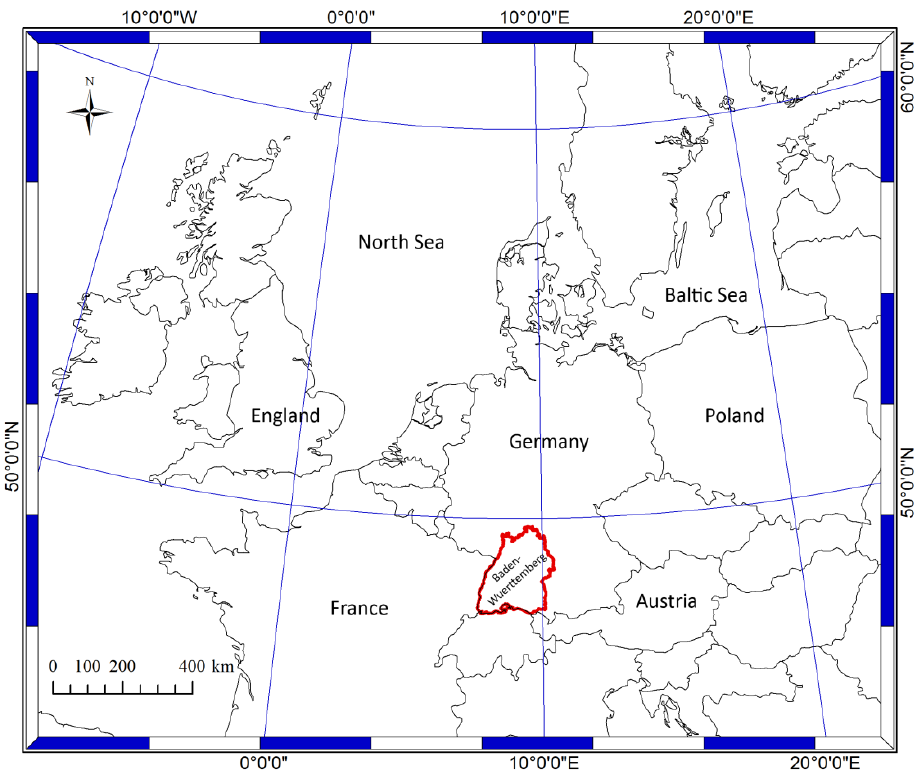
Figure 1. Extent of the study area Baden-Wuerttemberg in the southwest of Germany (red polygon).